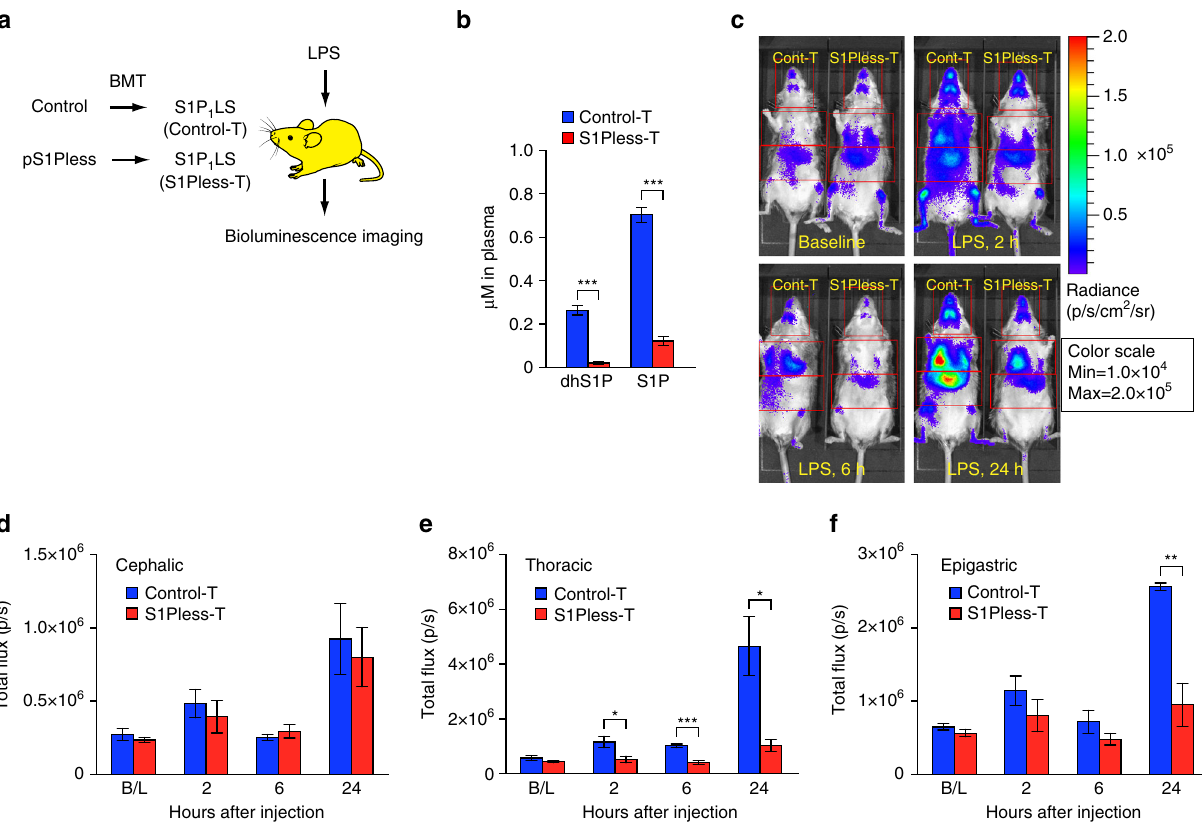
Fig. 5 S1P 1 activation during LPS-induced systemic in fl ammation in live mice transplanted with plasmaS1Pless bone marrow. a Bone marrow cells from control or plasma(p)S1Pless mice were transplanted (BMT) into irradiated S1P 1 luciferase signaling (S1P 1 LS) mice to produce control transplanted (Control- T) or pS1Pless transplanted (S1Pless-T) mice, respectively. LPS was injected intraperitoneally into the stably transplanted mice 20 weeks later. Mice were subjected to BLI prior to the LPS injection (baseline, B/L) and 2, 6, and 24 h after LPS injection. b Plasma S1P and dhS1P levels in S1P 1 luciferase signaling mice, transplanted with control (Control-T) or pS1Pless (S1Pless-T) bone marrow. Data represent the mean ± SEM. n = 6 for Control-T mice, n = 8 for S1Pless-T mice. c Representative bioluminescence images of the same S1P 1 luciferase signaling mice, transplanted with control (Cont-T) or pS1Pless (S1Pless-T) bone marrow, at the speci fi ed time points. Mice were imaged in the supine position. Red open rectangles representing ROI were positioned around cephalic, thoracic, and epigastric regions. d – f The bioluminescence activity was quanti fi ed by determining the total fl ux (photons/sec; p/sec) in the cephalic ( d ), thoracic ( e ), and epigastric ( f ) ROI. Data represent the mean ± SEM. n = 5 for control BM-transplanted S1P 1 luciferase signaling (Control-T) mice and n = 7 for pS1Pless BM-transplanted S1P 1 luciferase signaling (S1Pless-T) mice at the baseline, 2 h, and 6 h time points. n = 4 for control BM- transplanted S1P 1 luciferase signaling (Control-T) mice and n = 6 for pS1Pless BM-transplanted S1P 1 luciferase signaling (S1Pless-T) mice at 24 h. P values were determined two-tailed Student ’ t -test; * P ≤ 0.05, ** P ≤ 0.01, *** P ≤